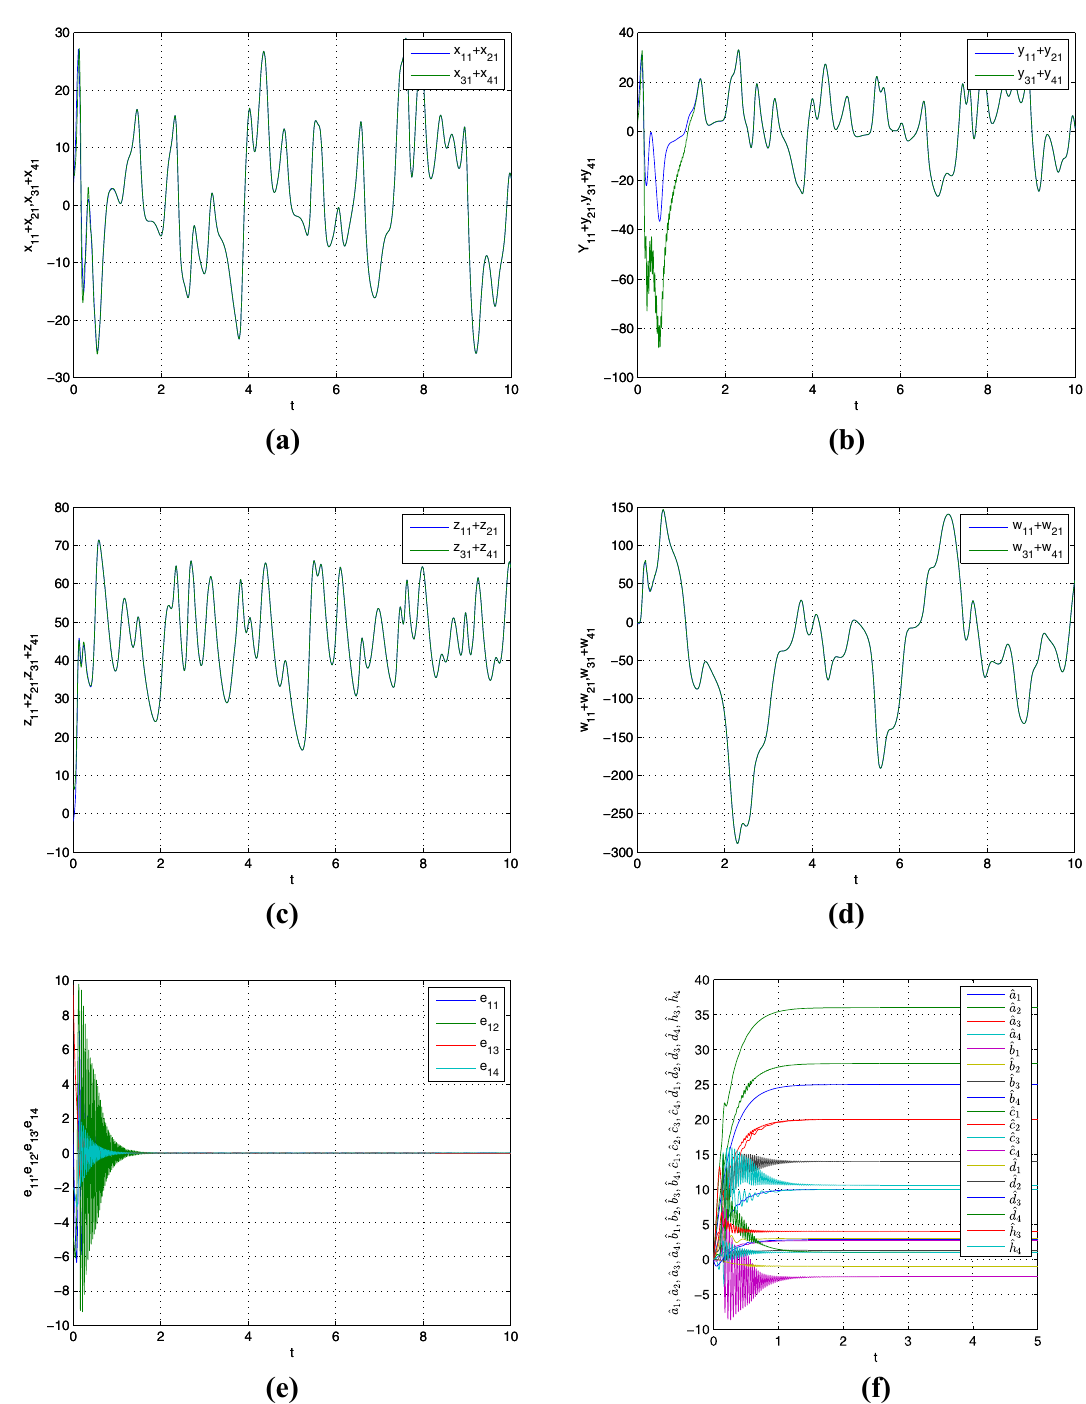
Fig. 3 Completesynchronizationof hyperchaoticsystems a between x 11 ( t ) + x 21 ( t ) and x 31 ( t ) + x 41 ( t ) , b between y 11 ( t ) + y 21 ( t ) and y 31 ( t ) + y 41 ( t ) , c between z 11 ( t ) + z 21 ( t ) and z 31 ( t ) + z 41 ( t ) , d between w 11 ( t ) + w 21 ( t ) and w 31 ( t ) + w 41 ( t ) , e synchronization errors e 11 , e 12 , e 13 , e 14 , f parameter estimation